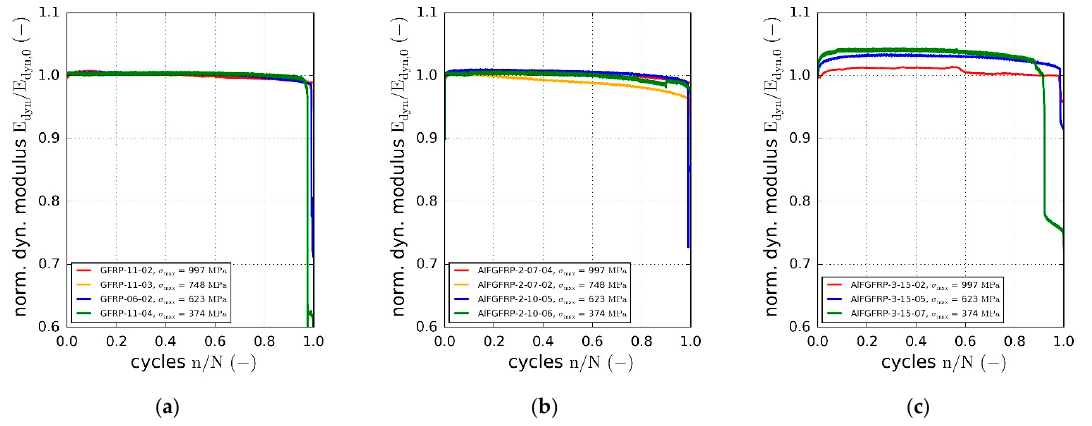
Figure 14. ( a ) Normalized dynamic modulus (tip–tip) against the normalized fatigue life: ( a ) refer- ence laminate; ( b ) laminate with work-hardened aluminum fibers; ( c ) laminate with soft-annealed aluminum fibers.